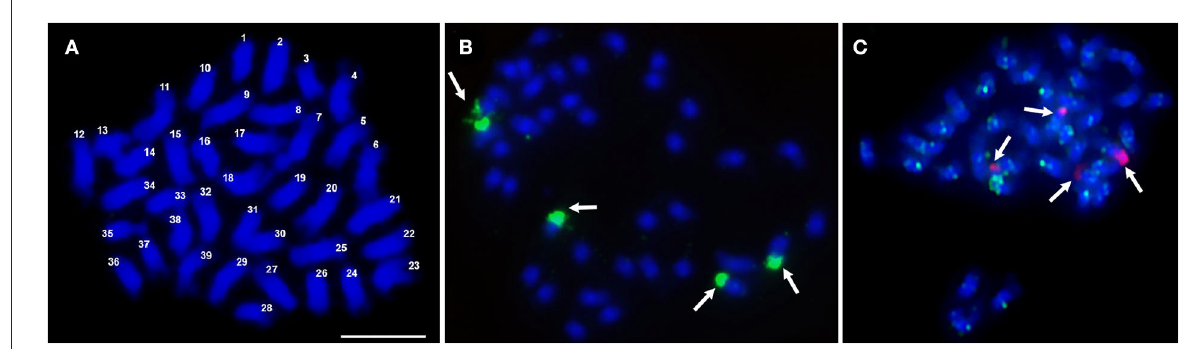
FIGURE1 Number of chromosomes and rDNA sites in Cenchrus ciliaris . (A) Metaphase spread of C. ciliaris after DAPI staining (blue) showing a chromosome count of 2 n = 4 x + 3 = 39. (B) Fluorescent in situ hybridization with 45S rDNA probe fluorescing green (arrows). (C) 45S rDNA probe (red) showing four major hybridization sites and Gy105 probe (green) hybridizing to most parts of the chromosomes. Scale bar = 10 µ m in (A) .